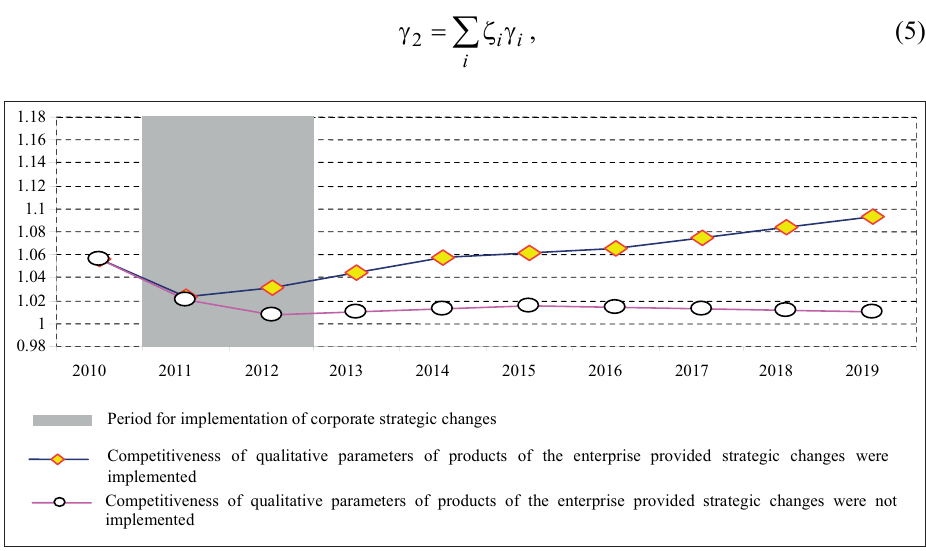
Fig. 1. Dynamics of the cumulative competitiveness index (γ